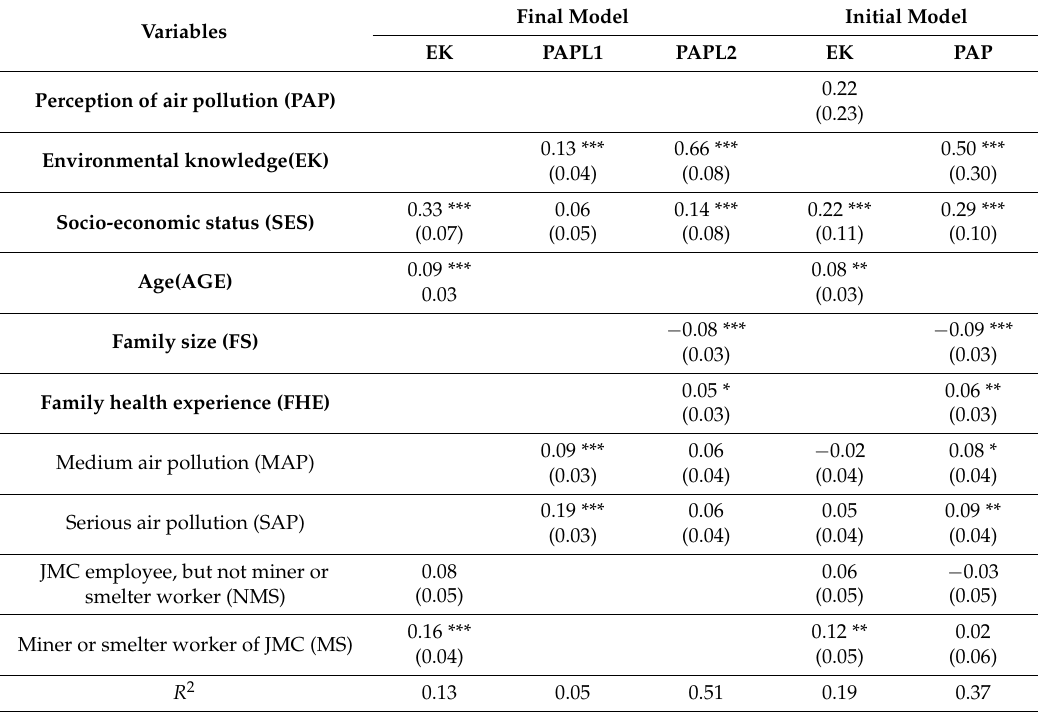
Table 4. The structural model (standardized